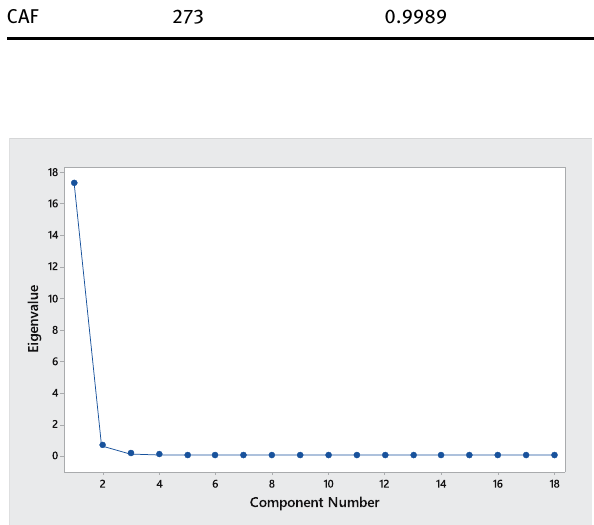
Figure 4: Diagram of eigenvalues obtained from chemometric data.